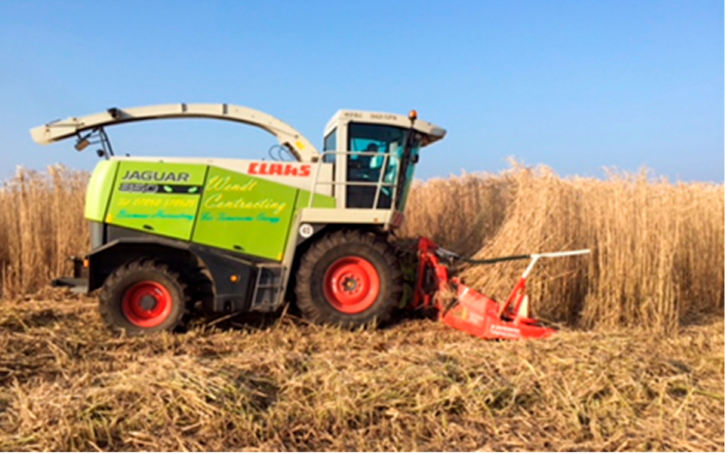
Figure 2. Miscanthus harvesting in a single pass using a self-propelled forage